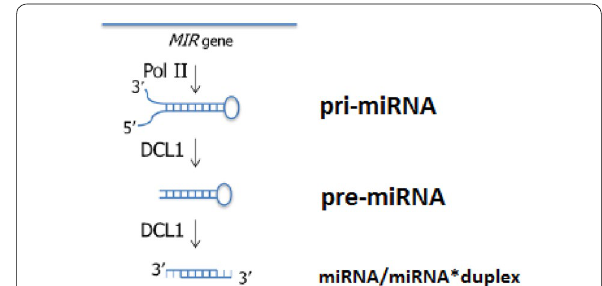
Fig. 1 Part of miRNA biogenesis route in plants. The main difference from animal biogenesis is that in plants, the two cleavages are performed by the same enzyme (DCL1) inside the nucleus instead of two different enzymes (Drosha, Dicer), one inside and one outside the nucleus. The two hanging nucleotides in each side of the duplex can be seen. After this process, the duplex exits the nucleus and separates